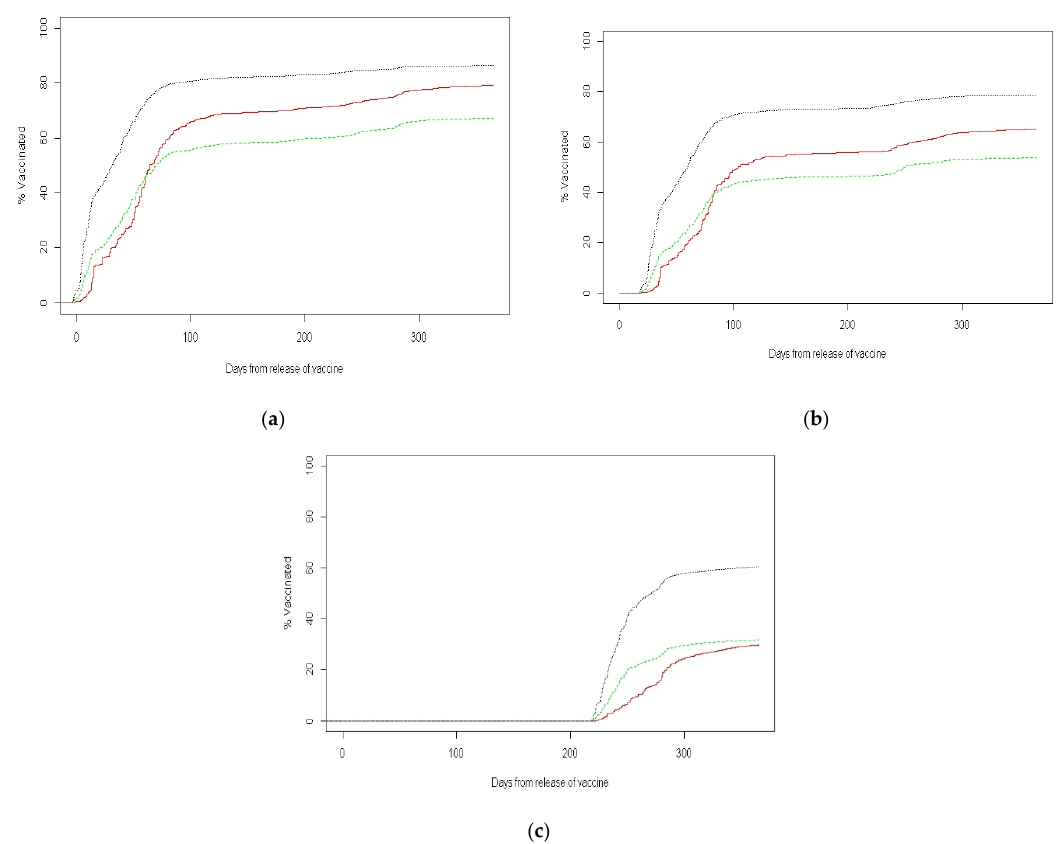
Figure 1. Cumulative rate with the time of vaccinated adults by sector. ( a ) First COVID-19 vaccine uptake; ( b ) second COVID-19 vaccine uptake; ( c ) third COVID-19 vaccine uptake. Table 3. Characteristics of study group by the number of COVID-19 vaccine doses